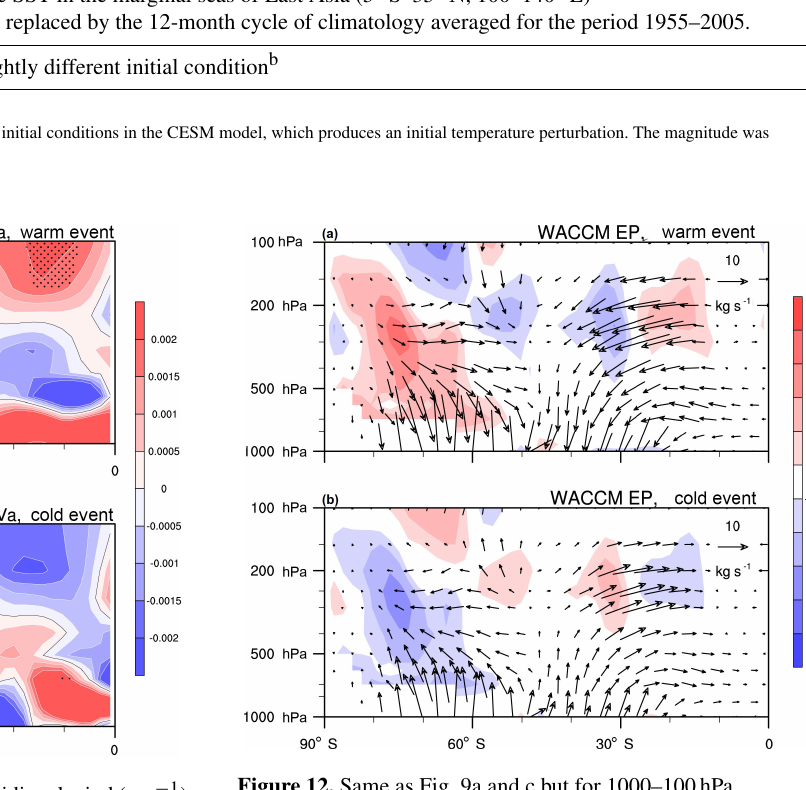
Figure 11. Zonal mean difference in TEM meridional wind (ms − 1 ) in austral spring between (a) S2 and S1, and (b) S3 and S1. Statis- tical significance above the 95% confidence level is stippled.